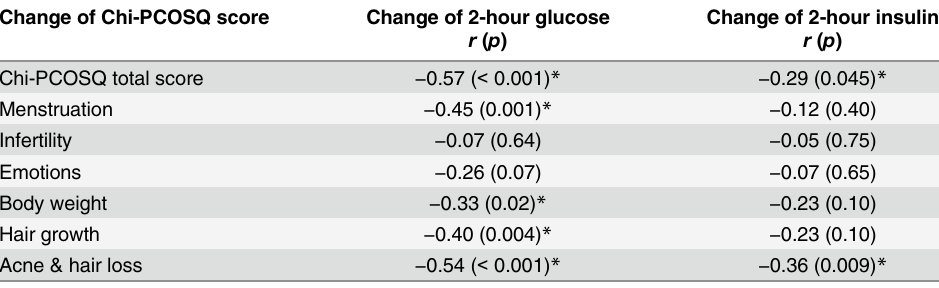
Table 3. Longitudinal validity of Chi-PCOSQ (n = 50).